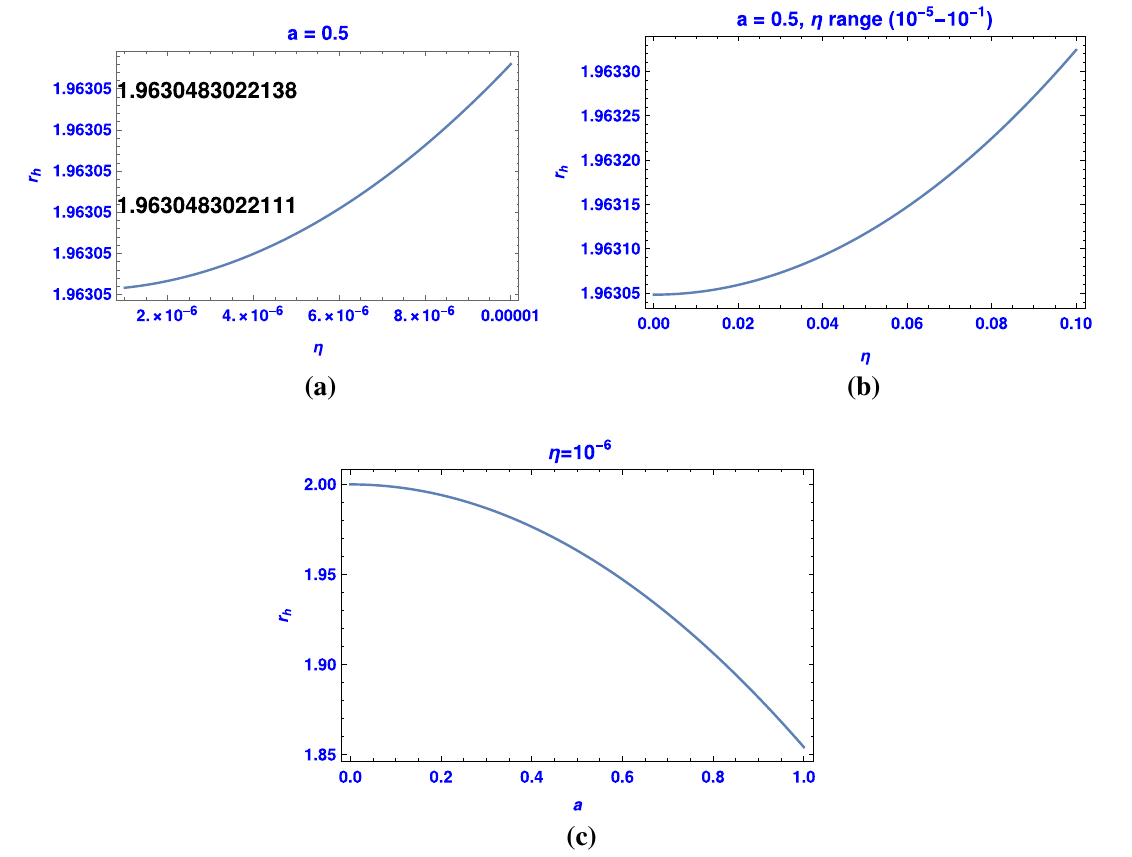
Fig. 2 The behaviour of horizon as a fuction of parameters η and a of the BH is plotted. In a ordinate is explicitly mentioned in black color as it change only after 12th decimal place for the small range of η ∼ 10 − 6 − 10 − 5 . In all the panels M is set to